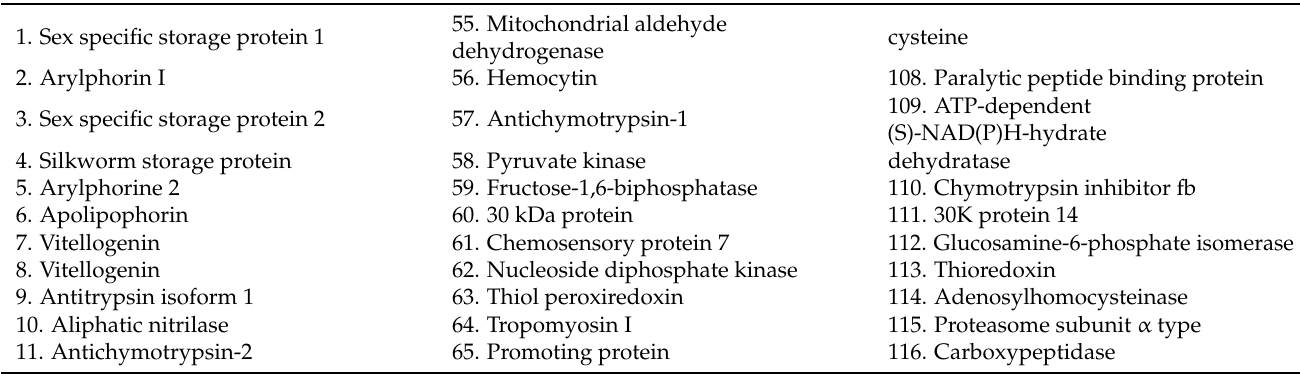
Table 1. List of proteins identified in the silkworm ( Bombyx mori ) pupae protein extract. Proteins are ranked by decreasing scores. Uncharacterized proteins and fragments from identical proteins were discarded from the